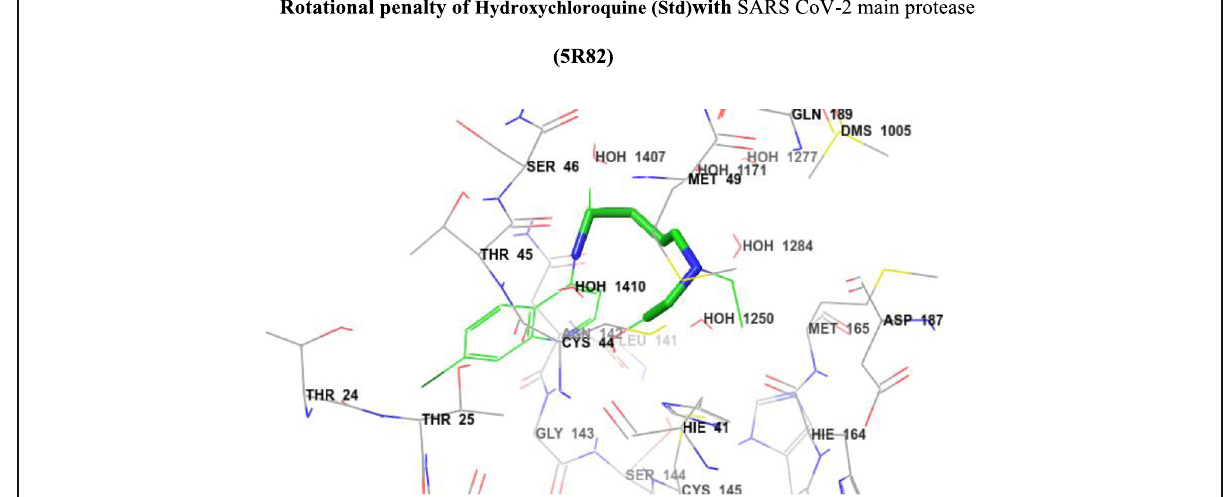
Fig. 7 Rotational penalty of hydroxychloroquine (Std) with SARS CoV-2 main protease